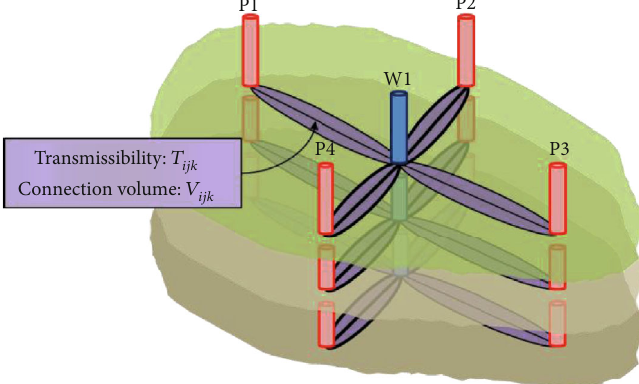
Figure 1: A sketch map of the INSIM in a multilayer